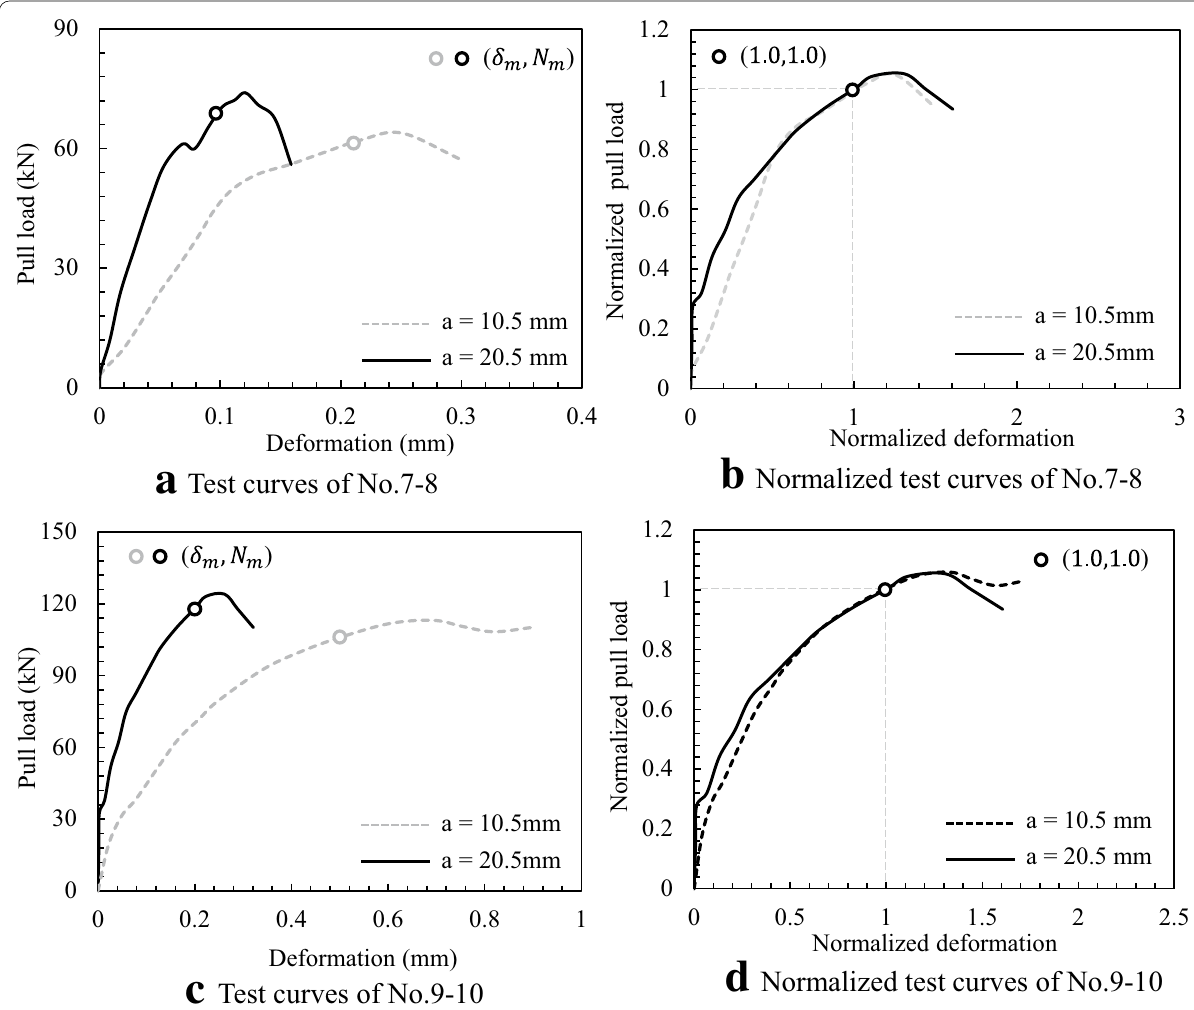
Fig. 10 Load–deformation curves of the anchorage concrete with different bearing